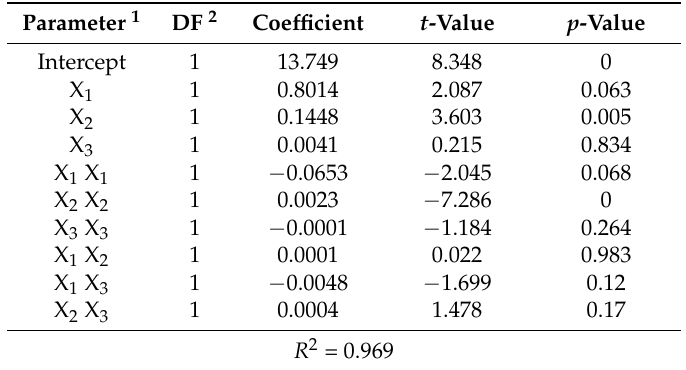
Table 3. The estimation of regression coefficients of the second-order polynomials for chlorophyll contents in the